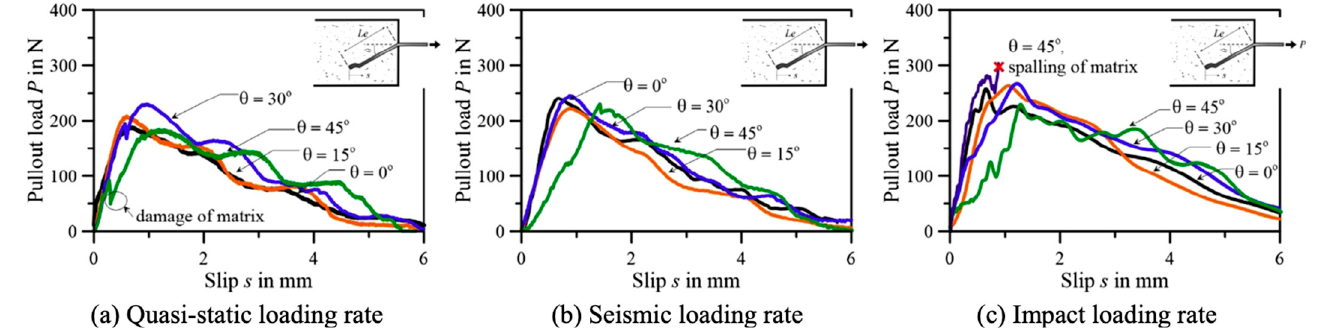
Figure 19. Average pull-out load vs. slip curves for H fibres embedded in UHPC under different loading rates and inclination angles: ( a ) quasi-static loading rate; ( b ) seismic loading rate; and ( c ) impact loading rate [26].